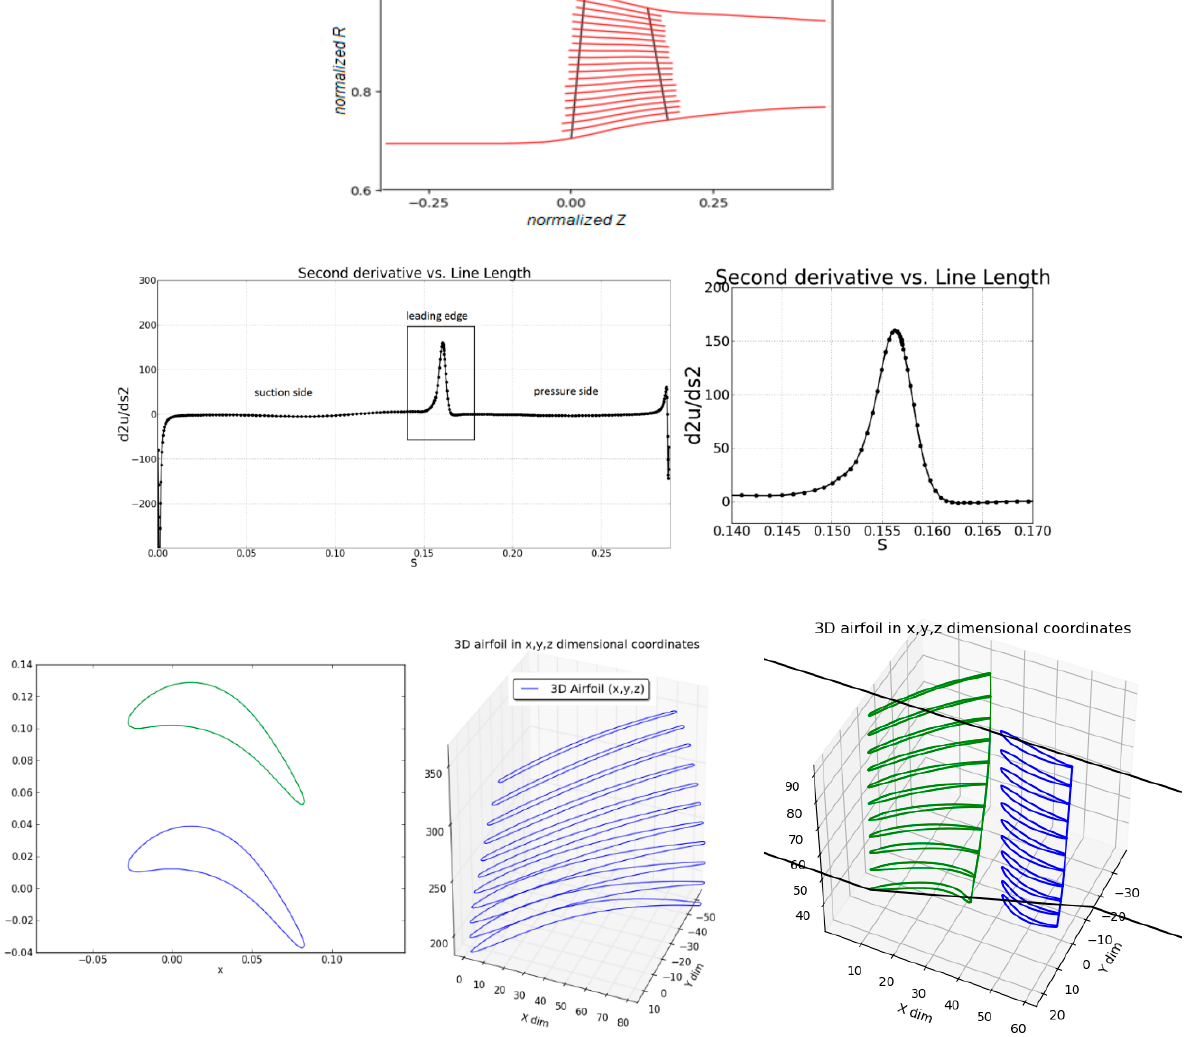
Figure 10. Meridional view of transonic compressor rotor, airfoil curvature, 2D cascade of an axial turbine rotor, 3D blade view of a compressor, and a sample turbofan stage 3D view as examples of blade visualizer in use.